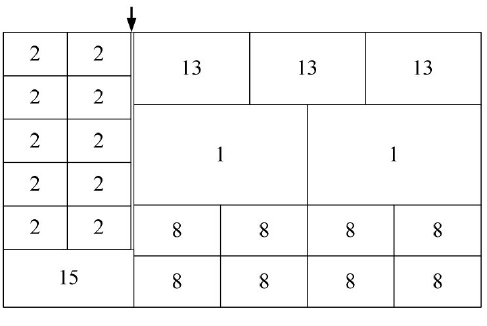
Figure 4. The segment